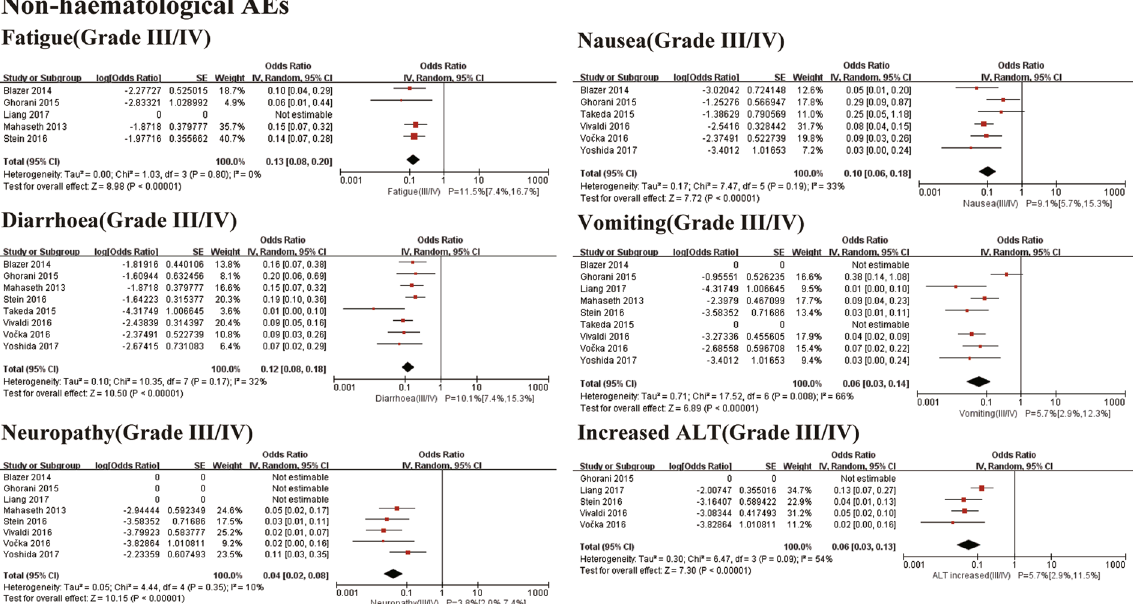
Figure 5. Meta-analysis for adverse events of non-haematological AEs. SE: standard error. IV: random-model generic inverse variance method. 95% CI: 95% confidence